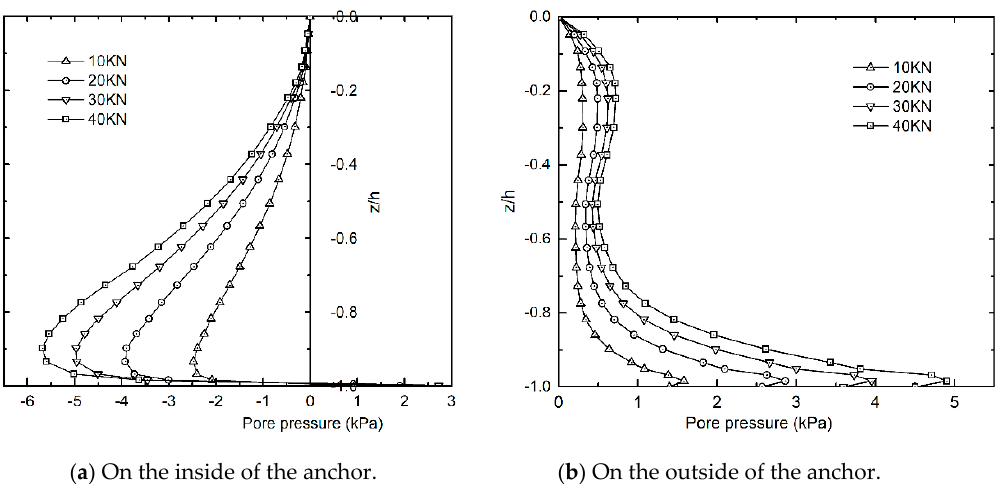
Figure 13. Vertical distribution of the residual pore pressures within the seabed along the anchor wall for various load amplitudes.